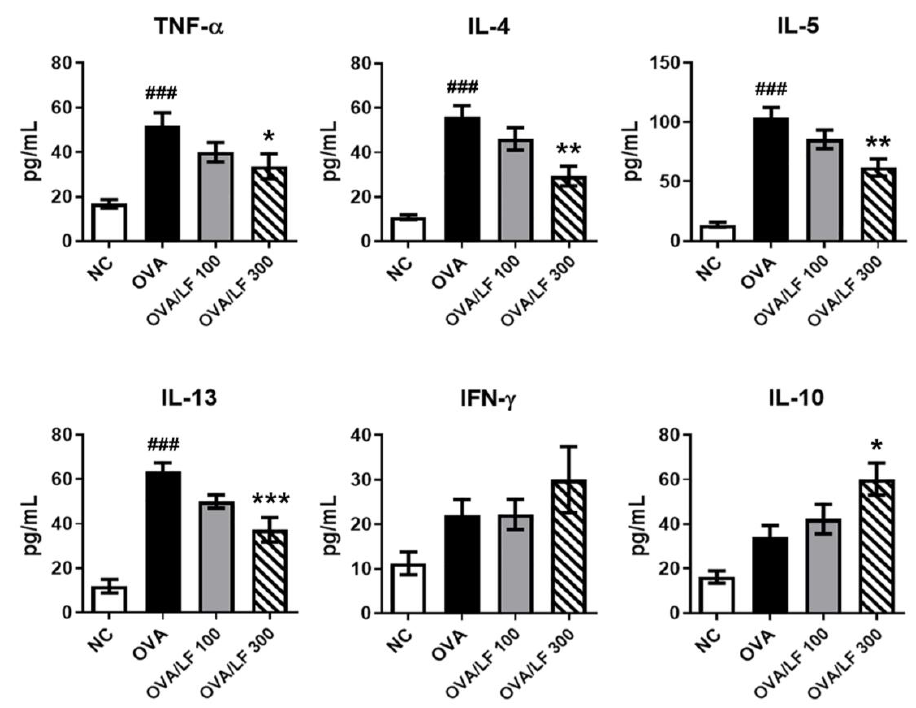
Figure 2. Effects of lactoferrin on Th2 cytokine production in BALF. The levels of TNF- α , IL-4, IL-5, IL-13, IFN- γ , and IL-10 in the BALF were detected by ELISAs. The data are expressed as the mean ± S.E.M. values ( n = 5). ### p < 0.001 vs. the NC group; * p < 0.05, ** p < 0.01, *** p < 0.001 vs. the OVA group. NC: Normal control; OVA: ovalbumin; OVA/LF 100: OVA + lactoferrin 100 mg/kg; OVA/LF 300: OVA + lactoferrin 300 mg/kg.